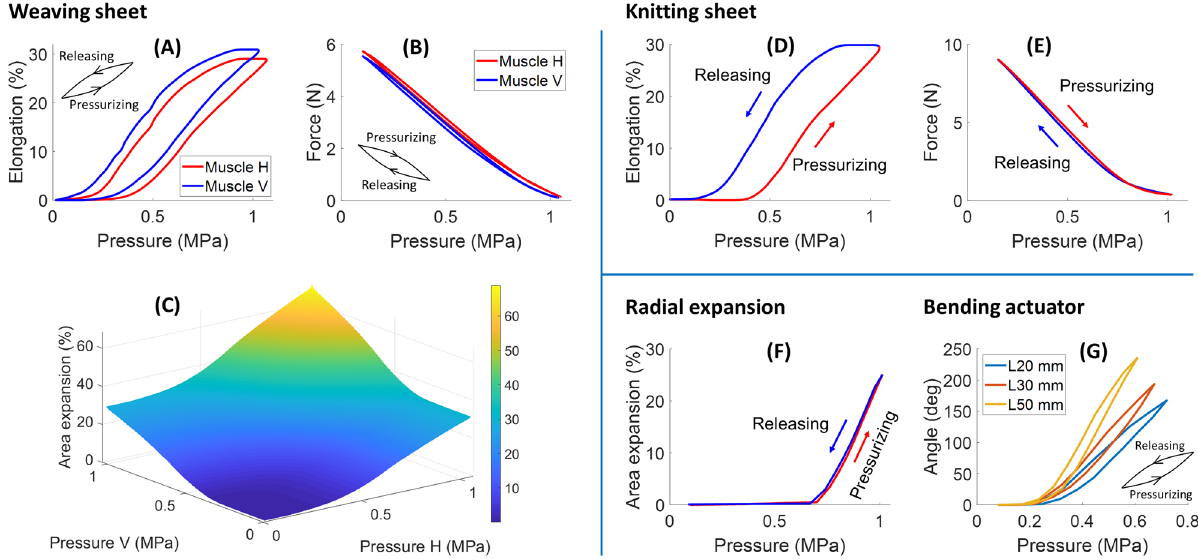
Figure 4. Characteristics of smart textile configurations. ( A , B ) Hysteresis profiles of input pressure and output elongation and force of the weaving sheet. ( C ) Area expansion of the weaving sheet. ( D , E ) Relationship between input pressure and output elongation and force of the knitting sheet. ( F ) Area expansion of the radial expansion structure. ( G ) Bending angles of three different lengths of bending